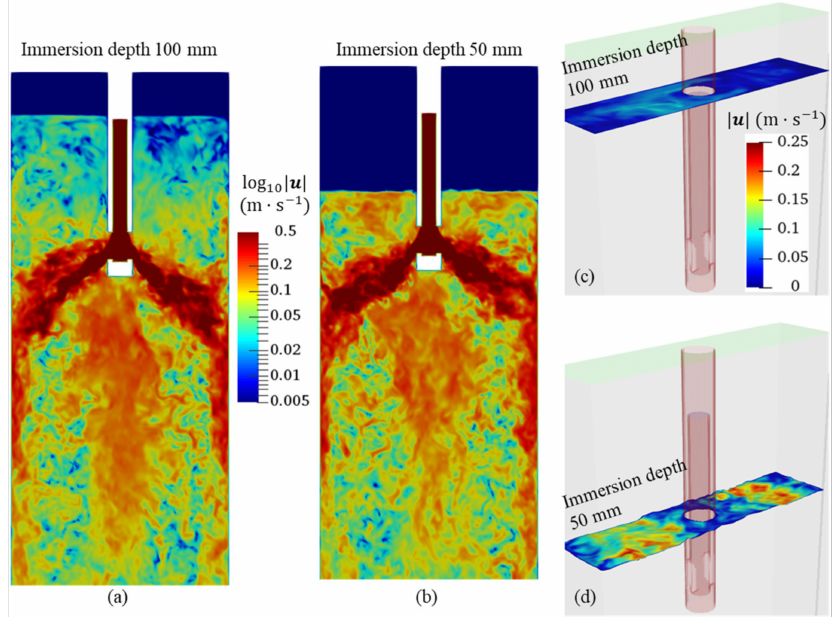
Figure 5. Modelling results for the non-EMBr Case 0A and Case 0B: ( a , b ) melt velocity (midplane); ( c , d ) velocity magnitude at the melt/air interface.